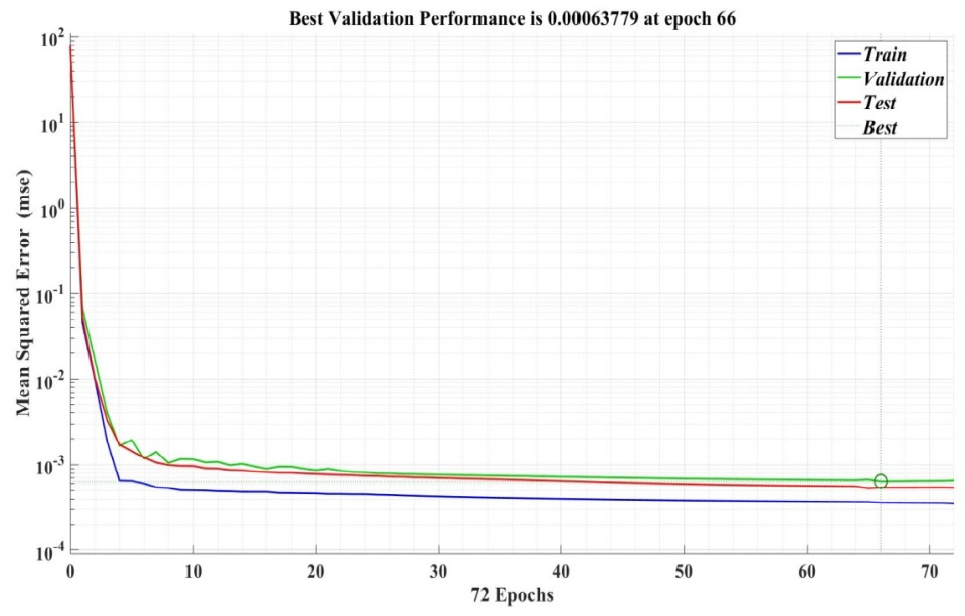
Figure 13. Performances of training for CO and CO 2 Analysis FFNN.